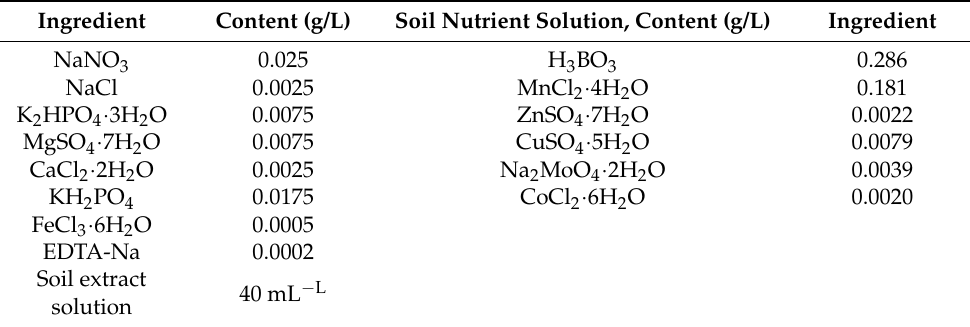
Table 1. The growth medium used for Turpin FACHB-507 was SE (pH 7.5). Ingredient Content (g/L) Soil Nutrient Solution, Content (g/L)